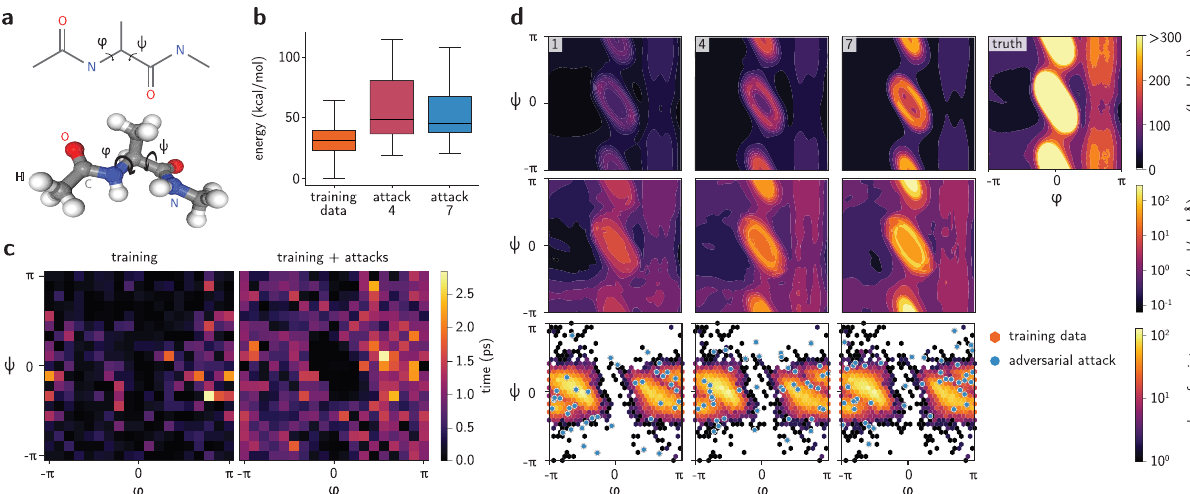
Fig. 5 Adversarial attacks applied to an alanine dipeptide molecule. a Schematic diagram of alanine dipeptide and the CVs ( φ , ψ ) created from the highlighted dihedral angles. Hydrogen, carbon, oxygen, and nitrogen atoms are depicted with white, gray, red, and blue spheres, respectively. b Distribution of force fi eld energies for conformations generated from the collective variables. The horizontal line is the median, the box is the interquartile region and the whiskers span the range of the distribution. c Duration of stable alanine dipeptide trajectories simulated with NN committees trained with and without adversarial examples. Grid points represent dihedral angles ( φ , ψ ) of the starting con fi gurations of trajectories obtained via rigid rotation of the lowest energy geometry. d Evolution of the PES of an NN committee trained on alanine dipeptide. Adversarial examples (blue points) are distortions along the CVs ( φ , ψ ) from randomly chosen original training points (hexagonal bins) through Eq. (13). Angles are given in